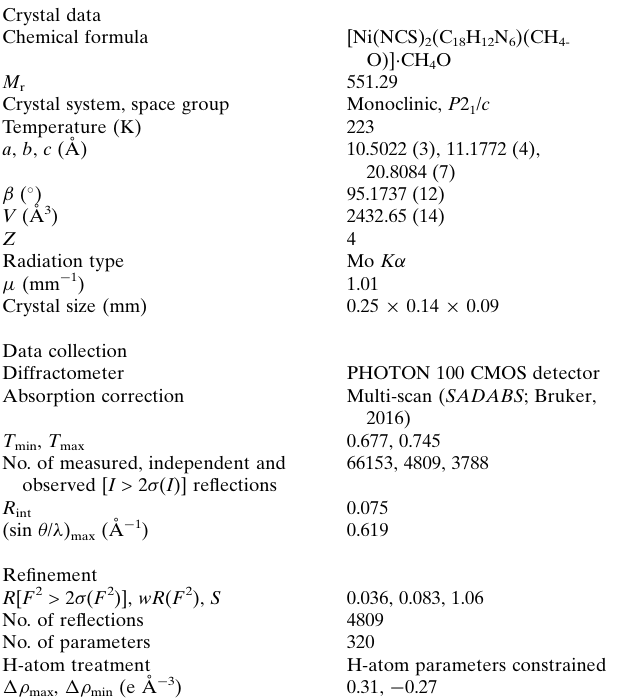
Table 2 Experimental details.